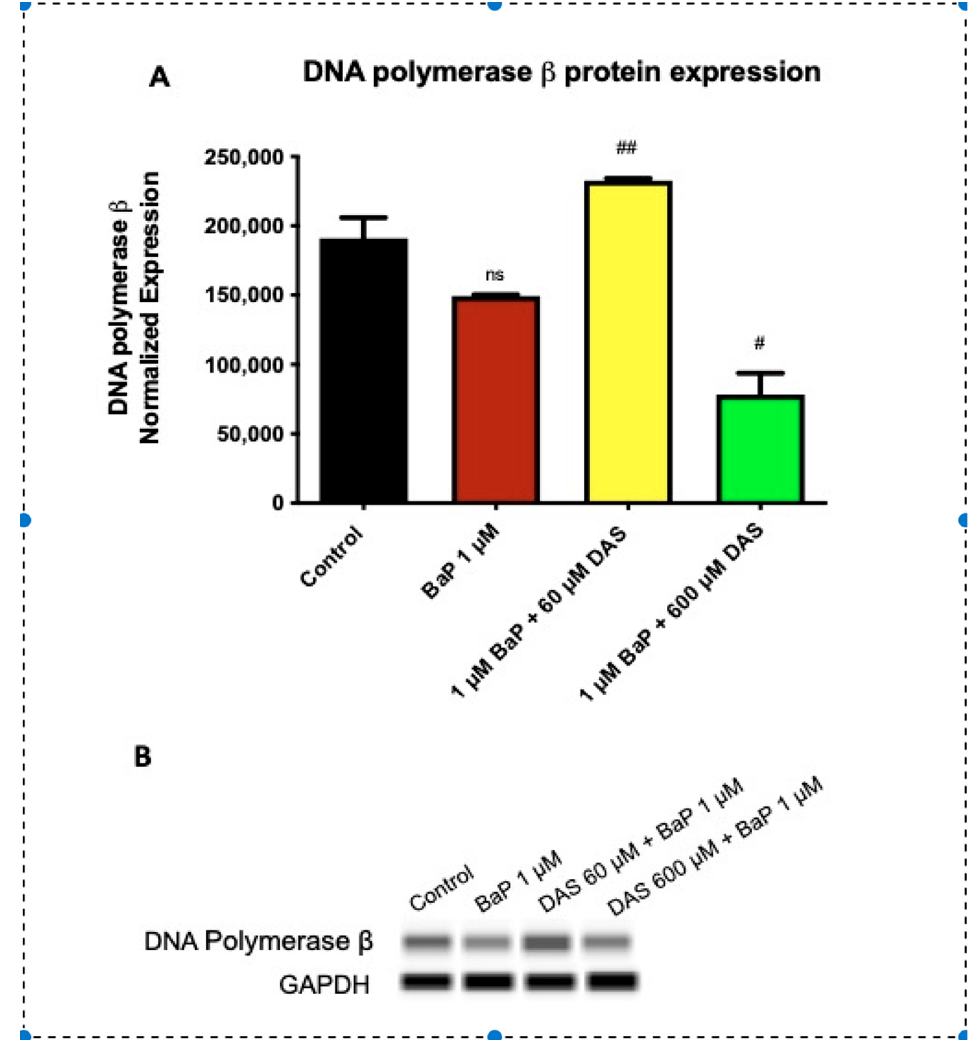
Figure 7. DAS and/or BaP effect on DNA Polymerase β (POL β ) expression in normal breast epithelial cells (MCF-10A) determined by Western analysis with automatic capillary electrophoresis. POL β expression is an indicator of base excision repair. ( A ) A graph of normalized protein expression of POL β measured by densitometry. ( B ) Electrophoretic bands represent the protein expression 24 hr-post treatment for POL β expression. A statistically significant difference of DAS CoTx compared to BaP treatment alone was evaluated by one-way ANOVA followed by Dunnett’s multiple comparison tests. In triplicate, +/ − SEM. # indicates p < 0.05, ## indicates p < 0.01 compared to BaP, and ns indicates p > 0.05 when compared to control.